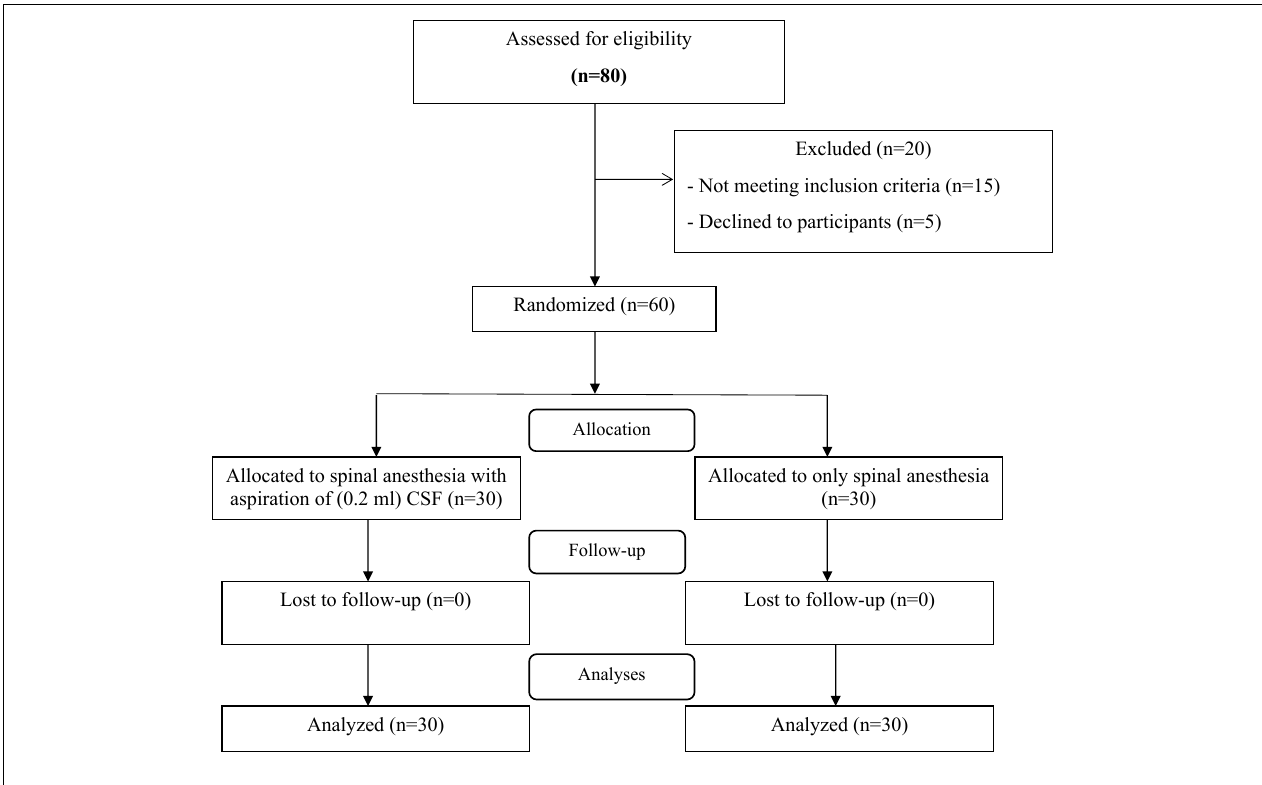
FIGURE 1 | CONSORT flow diagram. TABLE 1 | Baseline demographic and clinical characteristics in two groups of study.